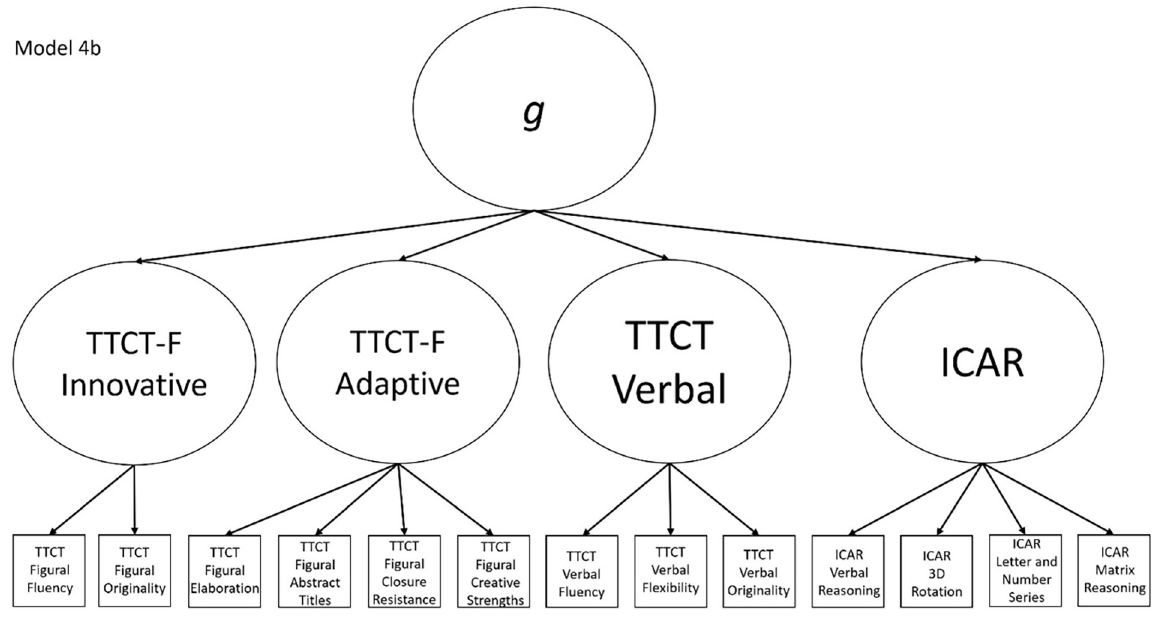
Fig 10. Confirmatory factor analysis diagram for model